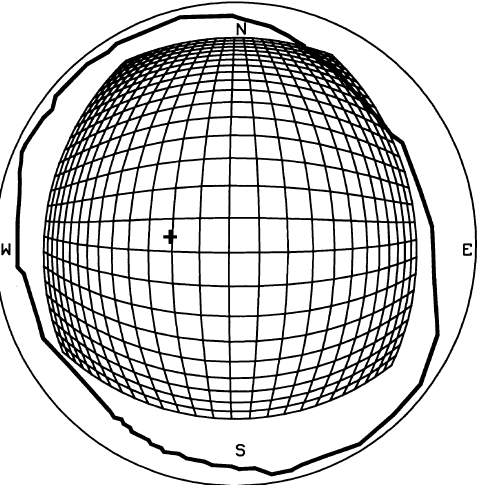
Fig. 1. The STARE field of view (67.6–72.6 (cid:176) N, 13.5–26.0 (cid:176) E) at an assumed altitude of 100 km as seen by DASI through an all-sky lens from Skibotn (69.35 (cid:176) N, 20.36 (cid:176) E) in geographic coordinates. The data grid is shown at the lower 20 (cid:180) 20 km resolution only for clarity. The position of EISCAT’s beam ( cross ) when magnetic field aligned is also shown for the same altitude. The circle is the ideal horizon whilst the heavy irregular circle is the actual